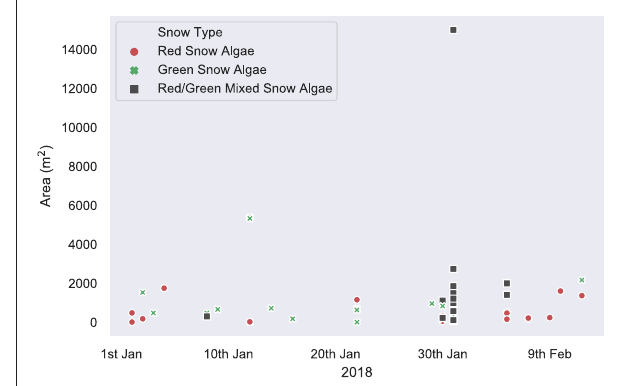
FIGURE 6 | In situ snow algal cell density. Measured in situ algal cell density within clean, visibly red or visibly green snow, sampled for life cycle analysis throughout the 2017/2018 growth season in the Ryder Bay area, Antarctica. Samples are from Rothera Point, Anchorage Island, Lagoon Island, and Léonie Island. Shaded area shows one standard deviation.